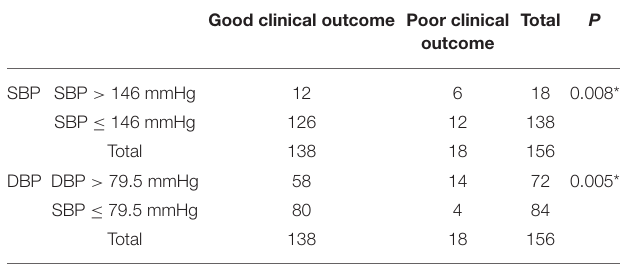
TABLE 4 | A higher rate of poor clinical outcome was found in CVT patients with SBP > 146 mmHg or DBP > 79.5 mmHg compared to those with SBP ≤ 146 mmHg or DBP ≤ 79.5